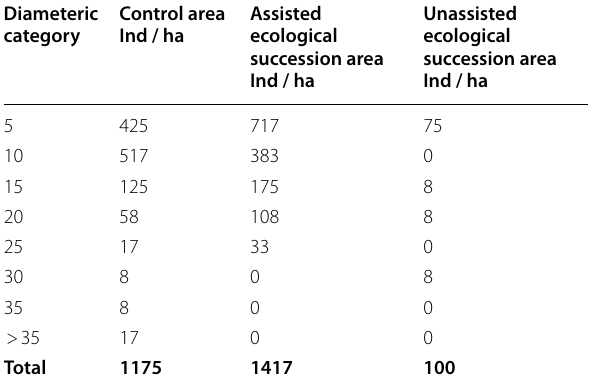
Table 2 Number of individuals per hectare in each diametric